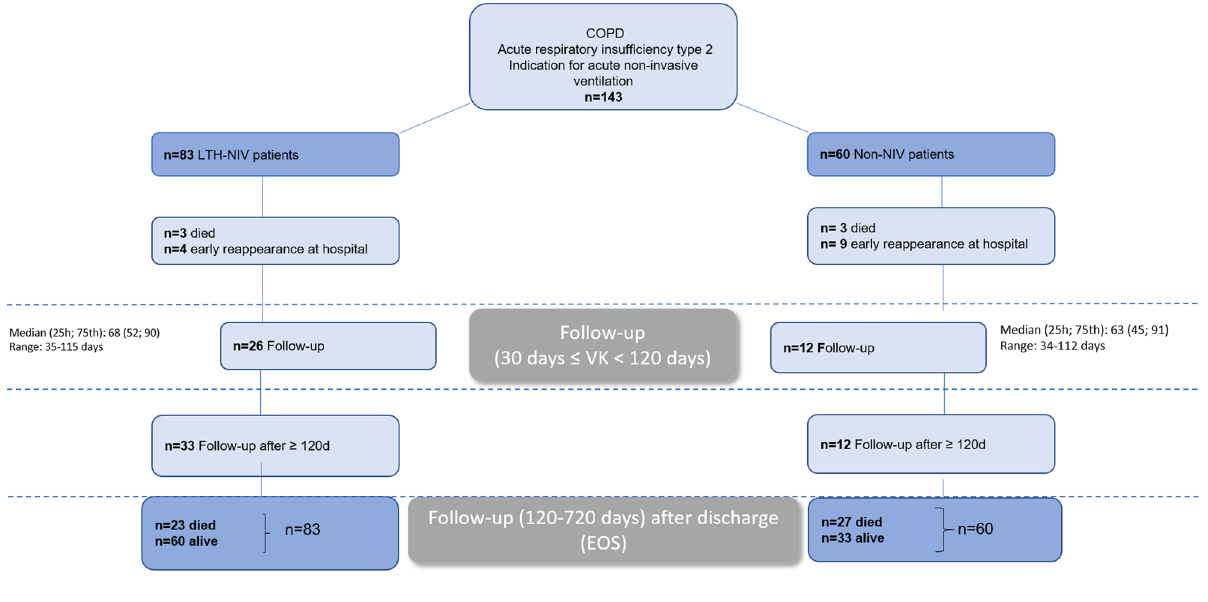
Figure 1. Flow chart of the study